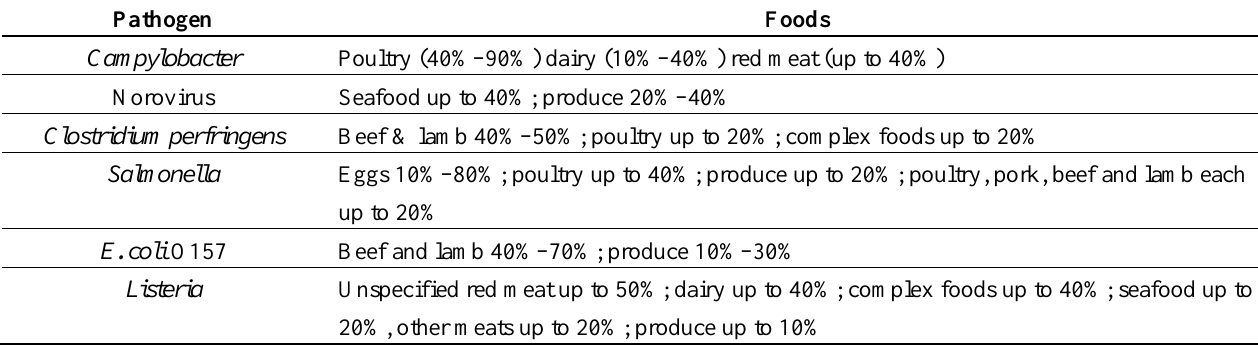
Table 7. Main foods associated with foodborne disease from food attribution studies in the UK, Canada, Denmark, the Netherlands, USA and the EU. Data from [3].